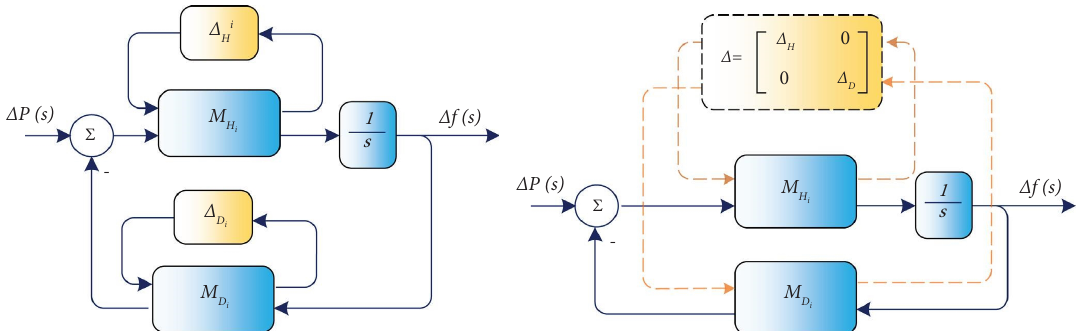
Figure 4: Determining uncertain blocks in the standard structure for robust control